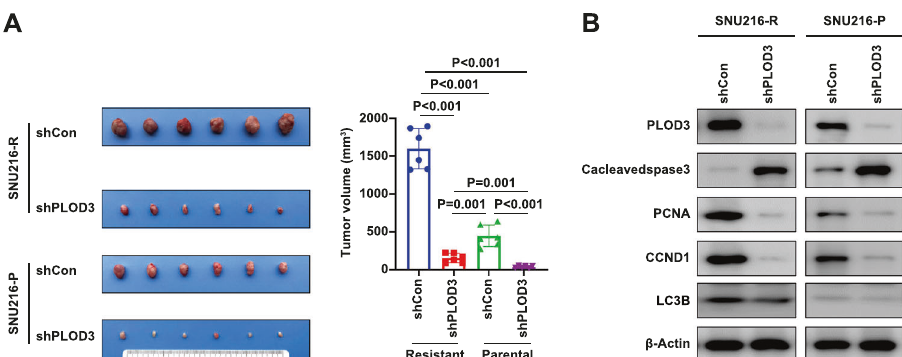
Fig. 2 PLOD3 was the key regulator for Trastuzumab resistance in gastric cancer in vivo. A In vivo evaluation of the effect of PLOD3 on tumor proliferation. B Examined cell proliferation and apoptosis of indicated tumor tissues derived from in vivo models by western